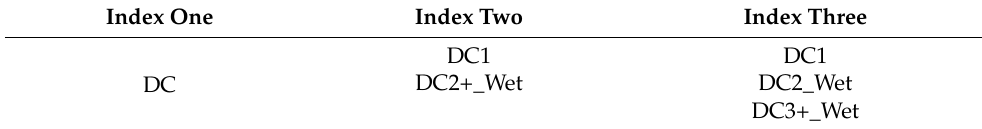
Table 4. Description of the different scenarios used in the index (description in Table